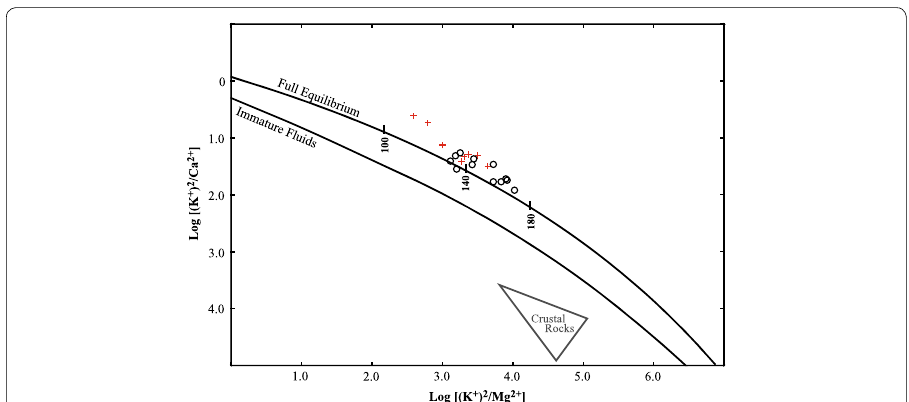
Fig. 3 Plot of K + /Mg 2 + versus K + /Ca 2 + ratios of the experimental fluids according to Giggenbach and Goguel (1989) (tonalite experiments black circles , andesite experiments red crosses ), illustrating the near equilibrium state of the